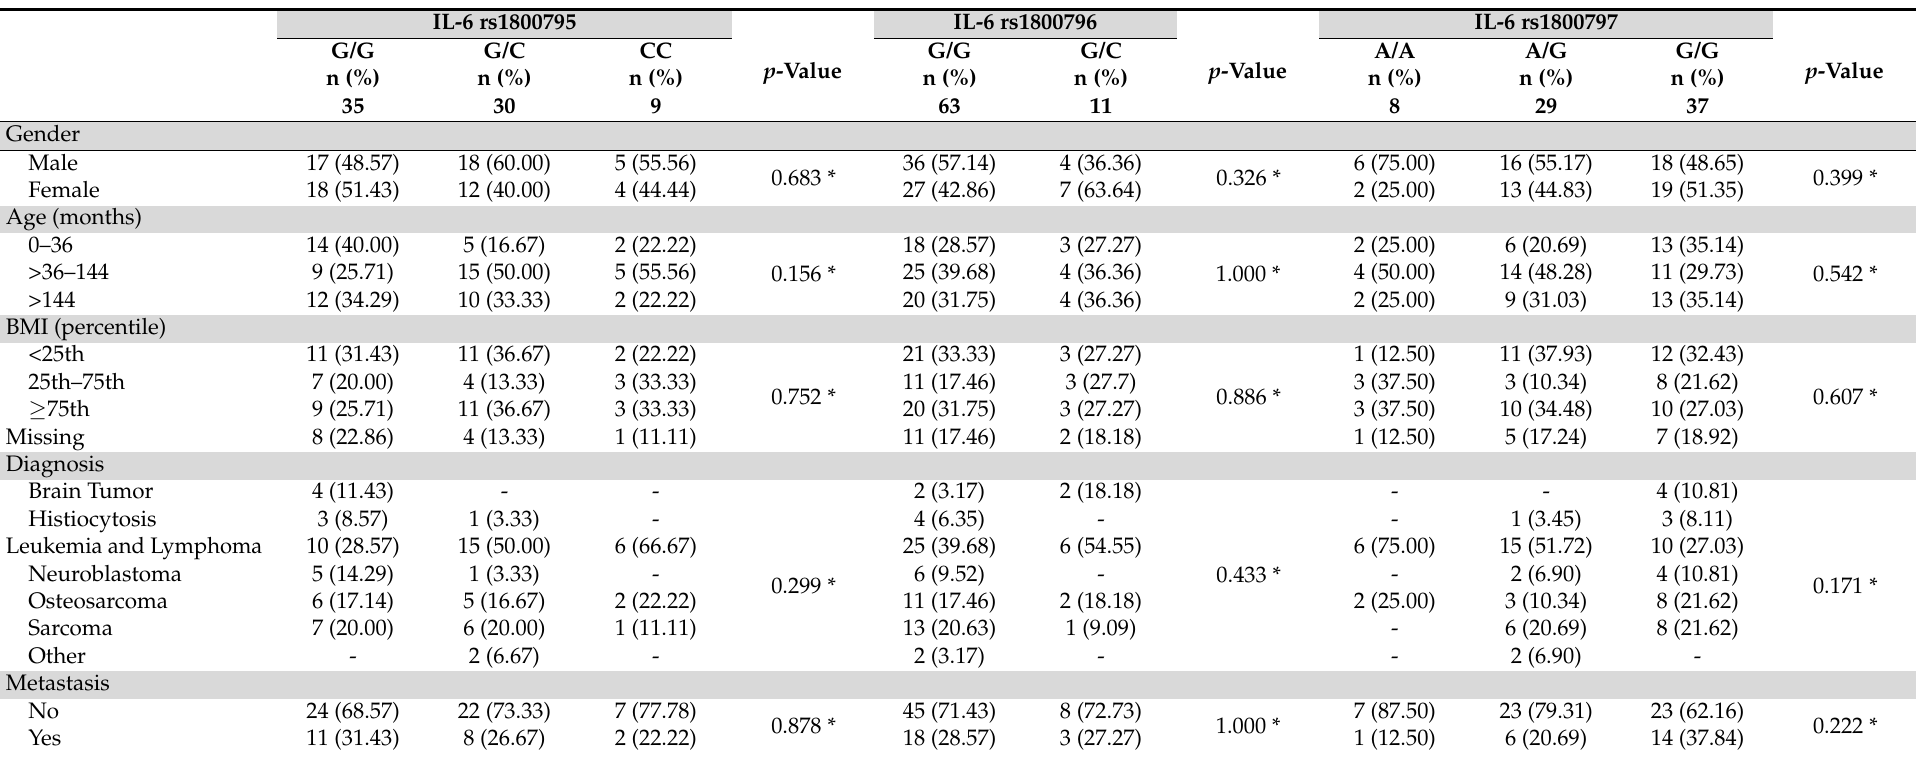
Table 2. Characteristics of the 74 subjects included in the STOP Pain Project and efficacy and safety parameters according to IL6 G174C, G572C, and A597G